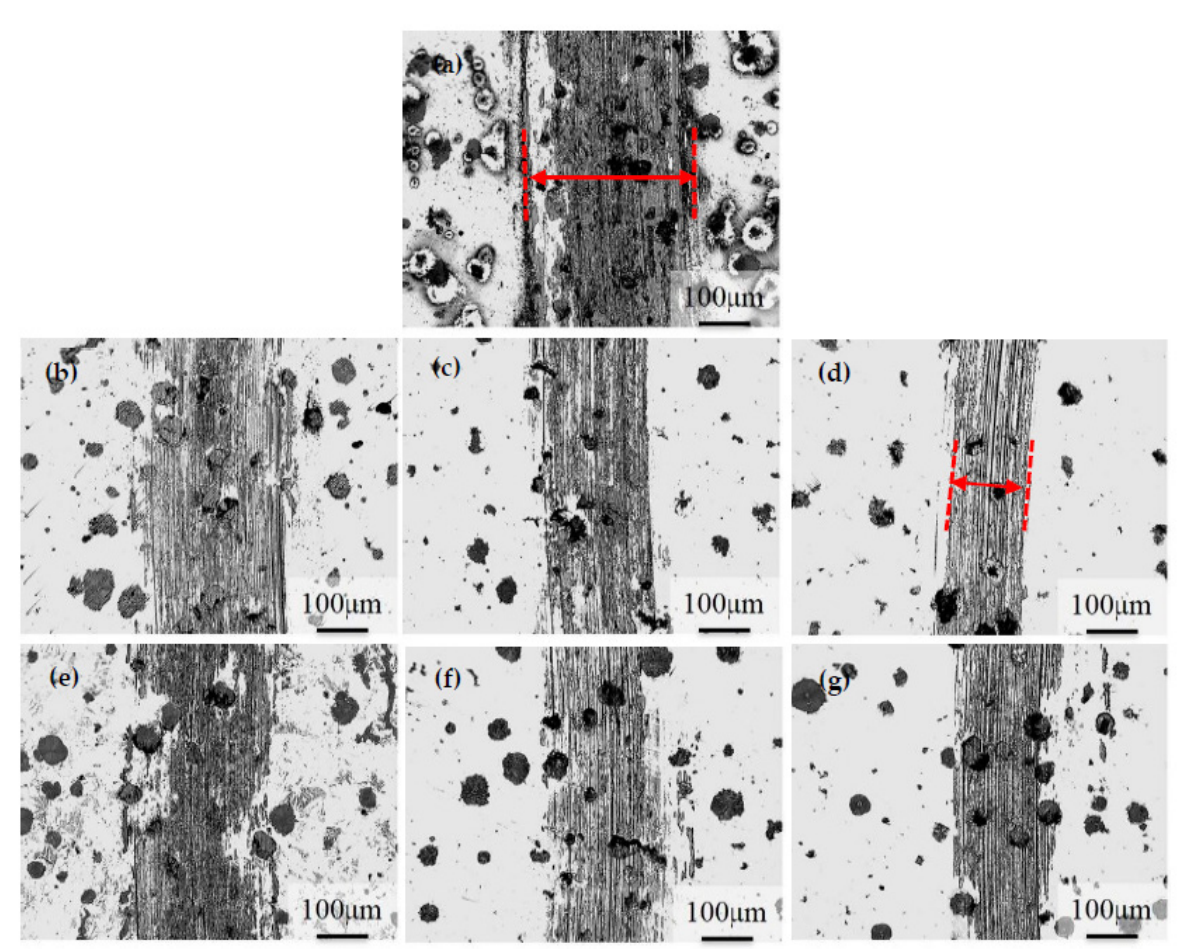
Figure 9. Surface worn tracks of the specimens after dry wear testing. ( a ) as-cast, ( b ) 300–1 h, ( c ) 300–5 h, ( d ) 300–10 h, ( e ) 360–1 h, ( f ) 360–5 h, and ( g ) 360–10